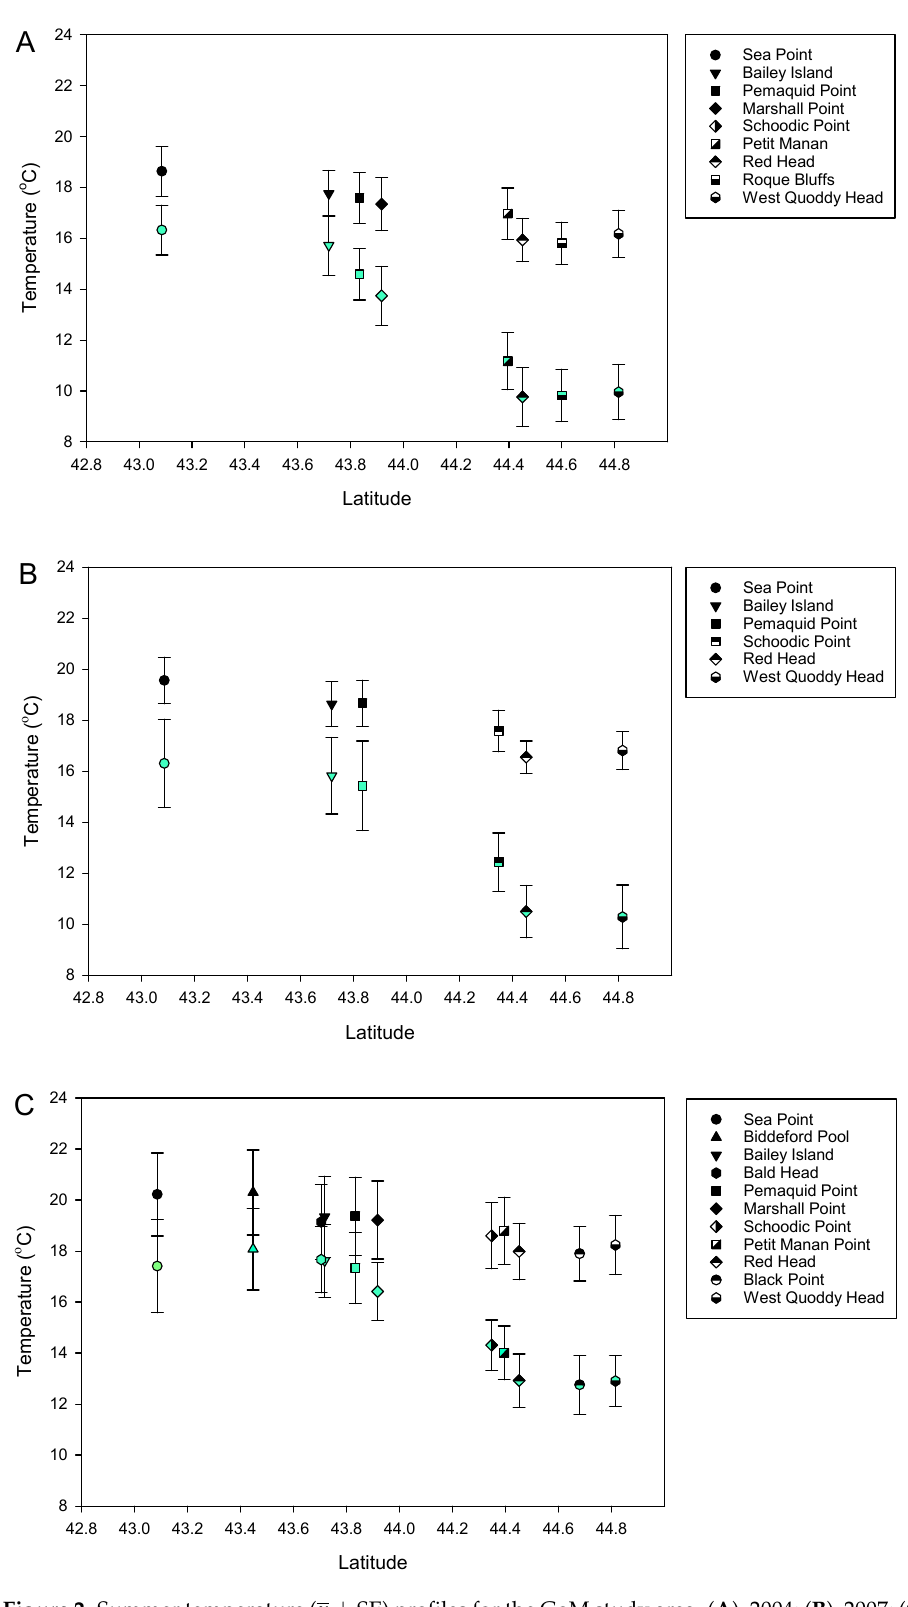
Figure 2. Summer temperature ( x ± SE) profiles for the GoM study area. ( A ), 2004; ( B ), 2007; ( C ), 2012. Symbology: Coastal land 2 m air temperature, black symbols; sea surface temperature, green symbols; filled symbols correspond to southern GoM region; half-filled symbols correspond to the northern GoM region.